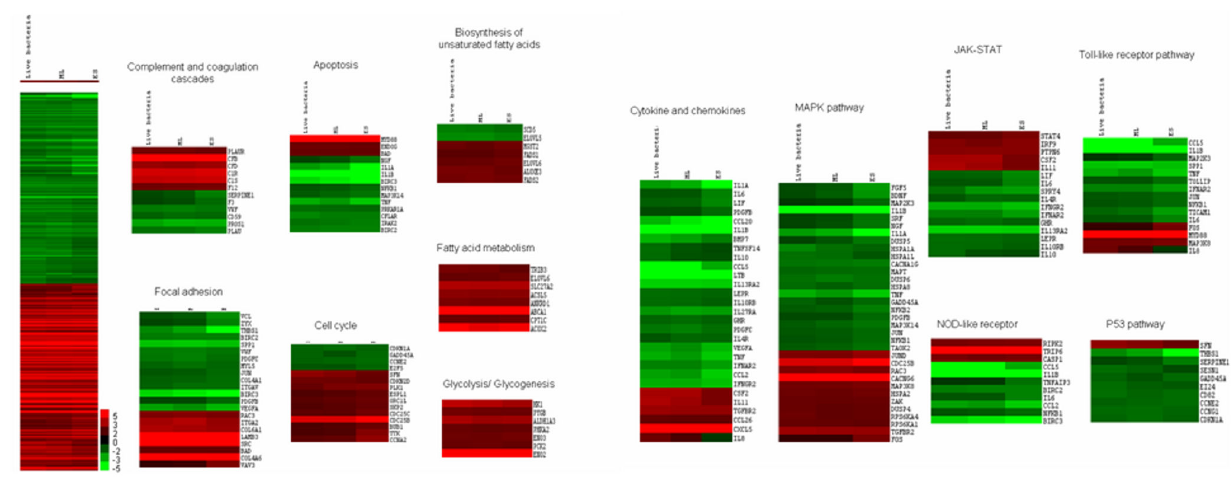
Figure 5. Heat map